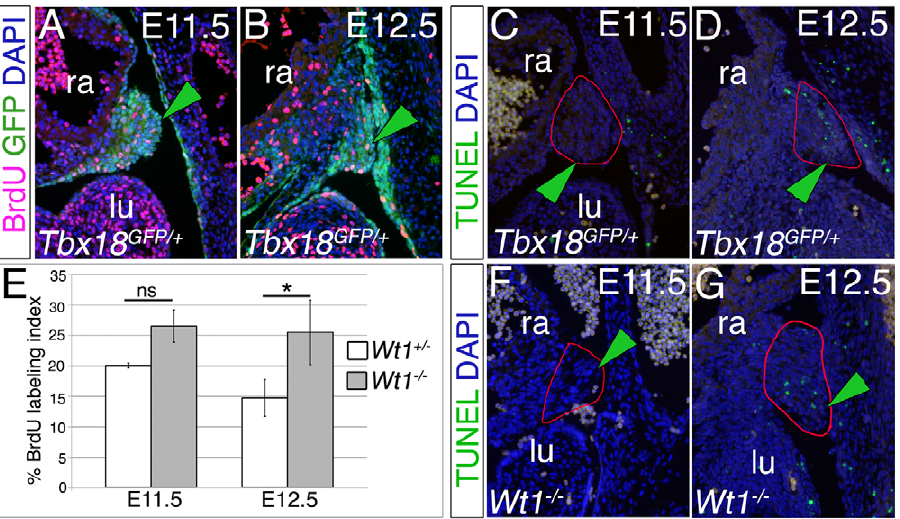
(green arrowheads) are highly proliferative and that apoptosis is absent. (E) Quantitative analysis of proliferation by the BrdU assay reveals non- significant changes of proliferation at E11.5 and significantly increased proliferation in Wt1 -deficient sinuatrial ridges at E12.5. (F, G) The TUNEL assay on sagittal sections through the heart of Wt1 2 / 2 at E11.5 and E12.5 shows that apoptosis is absent from mesenchymal ridges (green arrowheads) at these stages. lu, lung; ra, right atrium.